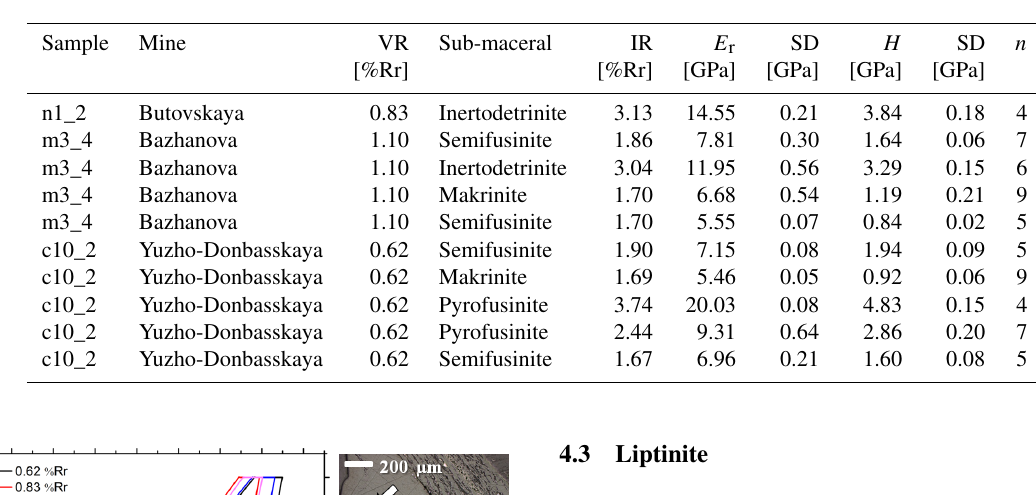
Table 3. H and E r averages determined for various inertinite sub-macerals, including standard deviations (SD) calculated from the respective number of measurements ( n ). Vitrinite reflectance (VR), indicative for the thermal maturity of the whole coal sample, was adopted from Sachsenhofer et al. (2003). Inertinite reflectance values (IR) of investigated inertinite macerals were measured during this study and reflect the conditions during pre-depositional wildfires, rather than thermal maturity related to burial. Note that inertinite reflectance refers to the actually indented macerals.